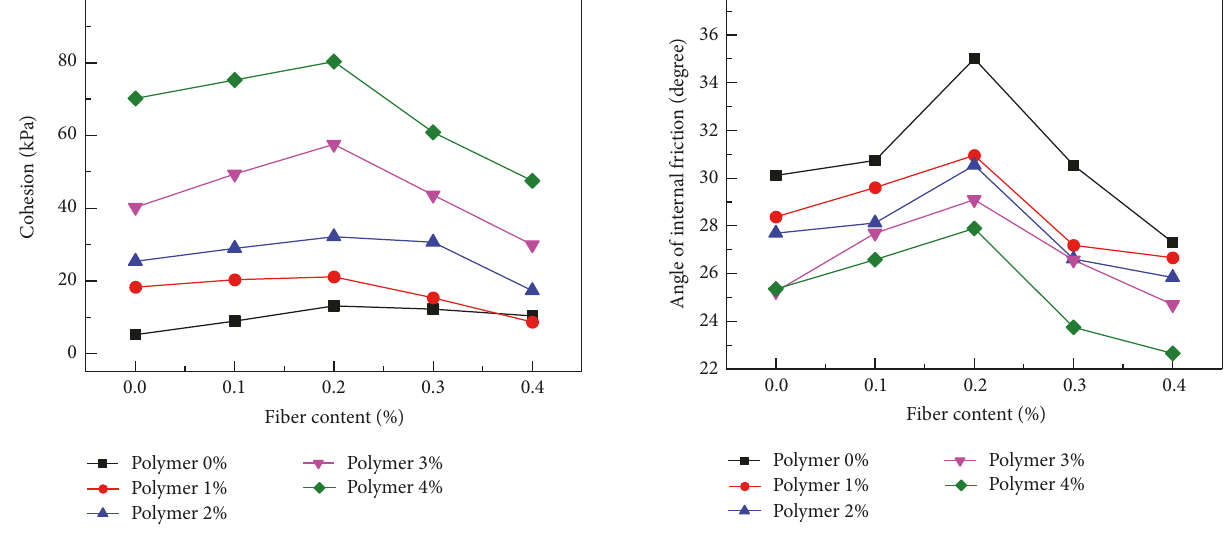
Figure 8: Cohesion of sand samples. Figure 9: Angle of internal friction of sand